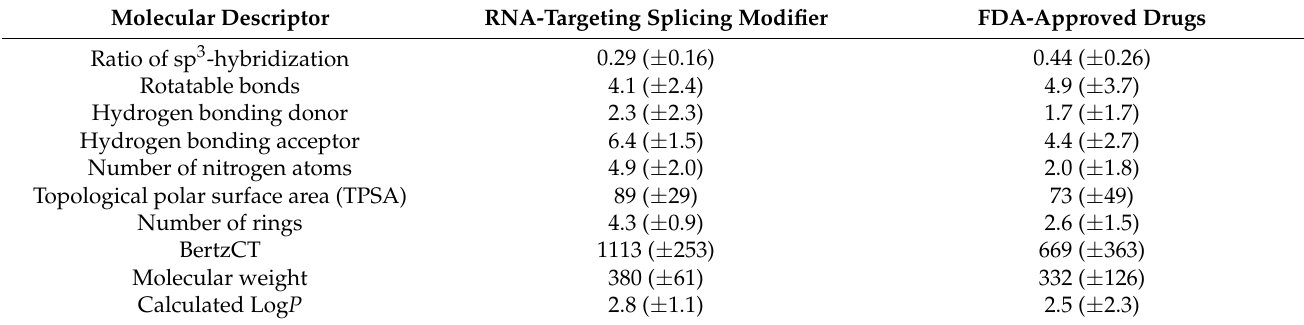
Table 4. Key physicochemical properties of the known splicing modifiers 1 and the FDA approved drugs (until 2008) 2 . Molecular